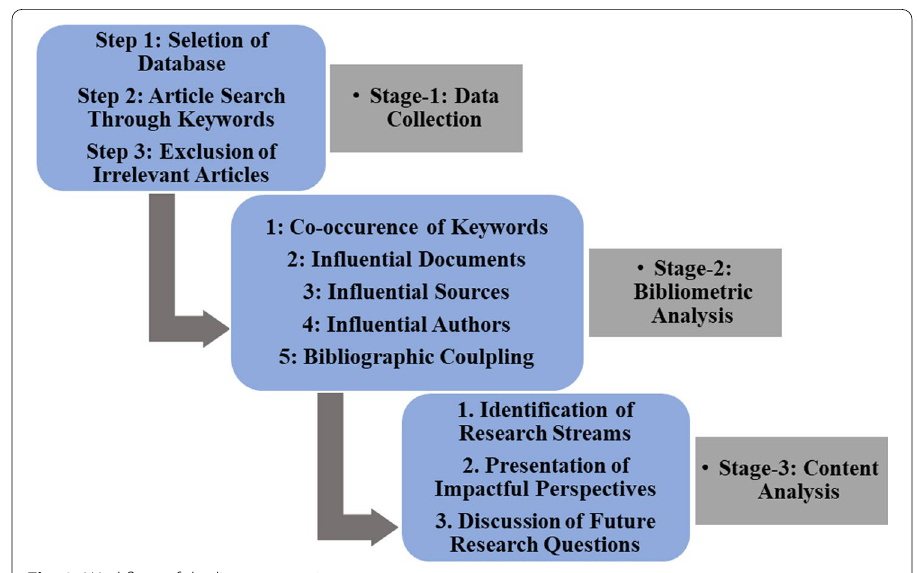
Fig. 3 Workflow of the literature review